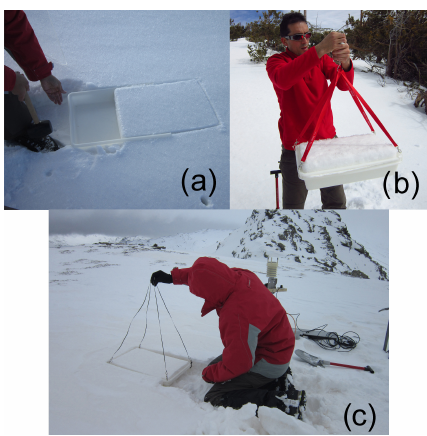
Figure 2. Photographs of the evaporation pan with lysimeter used in this study. In the sequence we can see (a) the load of the snow sam- ple by sliding of the upper tray, (b) handling of the complete device during weight, and (c) repositioning of the device to its measuring